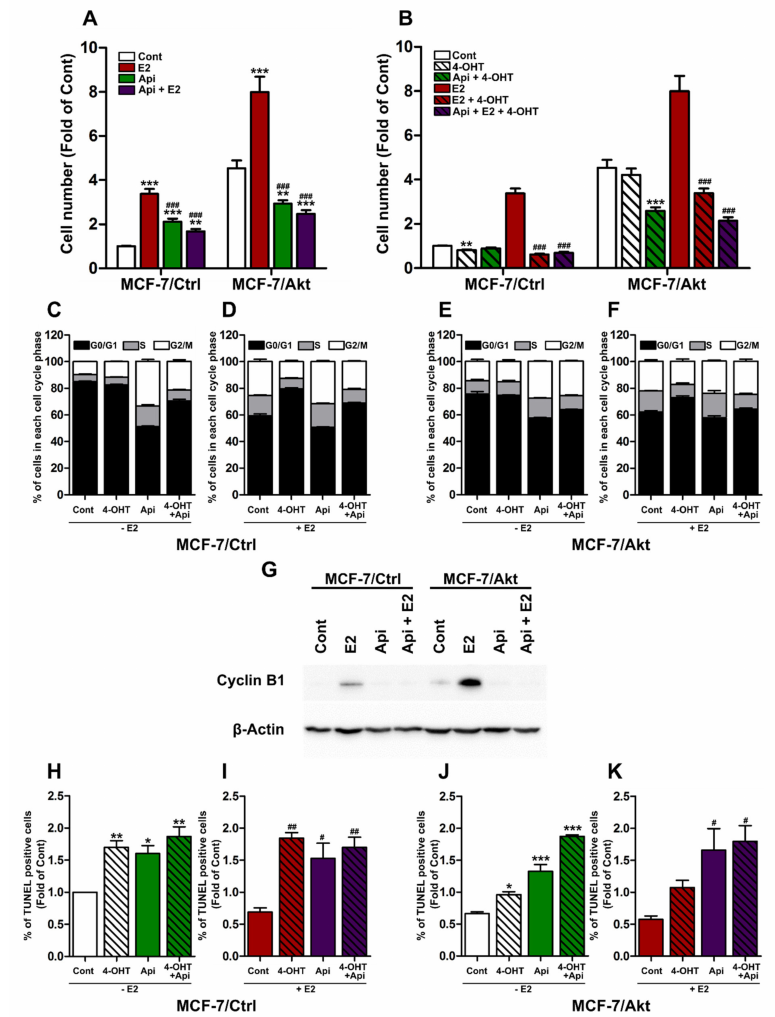
Figure 2. Effects of apigenin on the proliferation and cell cycle of MCF-7/Ctrl cells and MCF-7/Akt cells. ( A ) MCF-7/Ctrl cells and MCF-7/Akt cells were treated with solvent (0.1% ( v / v ) DMSO and 0.1% ( v / v ) ethanol) as the control (Cont), 1 nM estradiol (E2), or 10 µ M apigenin (Api) alone or in combination with E2. ( B ) MCF-7/Ctrl cells and MCF-7/Akt cells were treated with solvent (Cont) or 1 µ M 4-hydroxytamoxifen (4-OHT) alone or in combination with Api in the presence or absence of E2. Cell numbers were determined using the sulforhodamine B assay after 6 days of treatment. The experiment was conducted 3 times in quintuplicate. The results are expressed as the fold change in cell number compared with that in the control MCF-7/Ctrl cells and are presented as the mean ± SEM. For the cell cycle assays, MCF-7/Ctrl cells ( C , D ) and MCF-7/Akt cells ( E , F ) were treated with solvent (Cont), 4-OHT and Api alone or in combination in the presence or absence of E2 for approximately 24 h. The cell cycle was analyzed by flow cytometry after propidium iodide staining. The experiment was conducted 3 times. The results are expressed as the percentage of cells in each phase of the cell cycle and are presented as the mean ± SEM. ( G ) Equal amounts of protein extracts from MCF-7/Ctrl cells and MCF-7/Akt cells were analyzed by Western blotting with antibodies specific for cyclin B1 and β -actin. MCF-7/Ctrl cells and MCF-7/Akt cells were treated with solvent (Cont), E2 and Api alone or in combination with E2 for 24 h. For apoptosis analysis, MCF-7/Ctrl cells ( H , I ) and MCF-7/Akt cells ( J , K ) were treated with solvent (Cont), 4-OHT and Api alone, or in combination, in the presence or absence of E2 for approximately 24 h. Apoptotic cells were detected using terminal deoxynucleotidyl dUTP nick end labeling (TUNEL) assays. The experiment was conducted 3 times. The percentage of apoptotic cells was quantified and expressed as the fold change of the Cont-treated of the MCF-7/Ctrl clone. The results are presented as the mean ± SEM. Statistical analyses were performed with one-way ANOVA followed by Tukey’s post hoc test. * p -value < 0.05, ** p -value < 0.01, *** p -value < 0.001 indicate significant differences from the control group in the same clone. # p -value < 0.05, ## p -value < 0.01, ### p -value < 0.001 indicate significant differences from the E2 group in the same